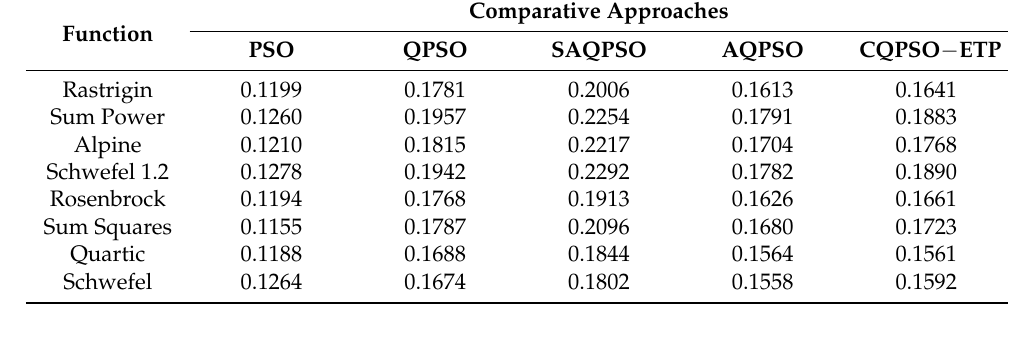
Table 4. Mean time taken by comparative approaches on eight numerical benchmark functions (Units: second).